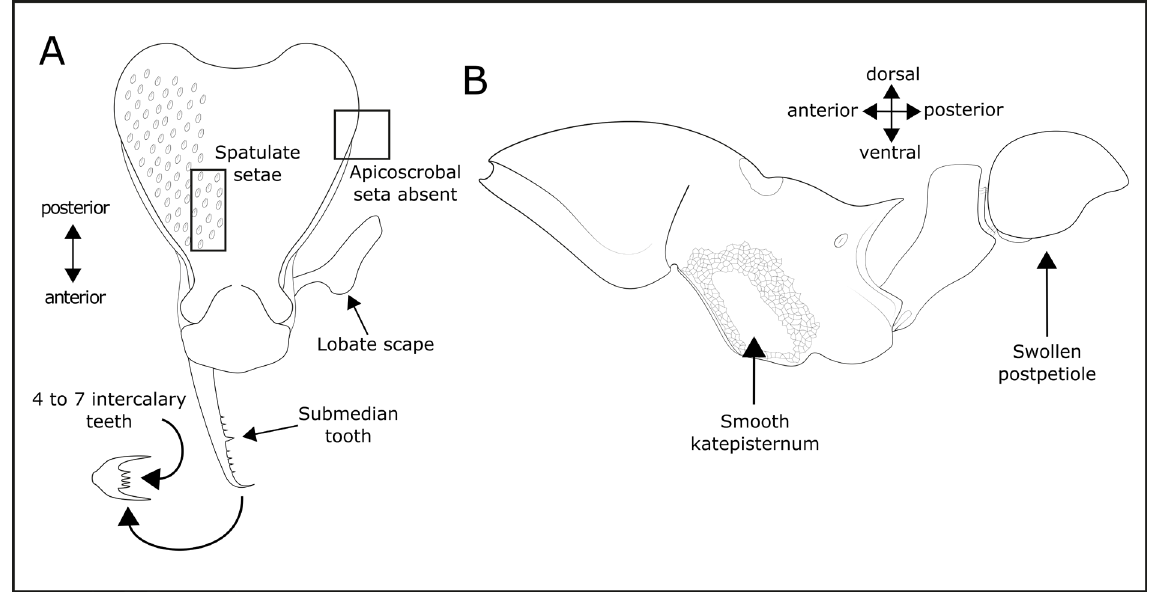
Fig. 2. Generalized schematics of Strumigenys crassicornis Mayr, 1887, showing useful identification features. A . Head in dorsal view. B . Mesosoma, petiole, and postpetiole in lateral